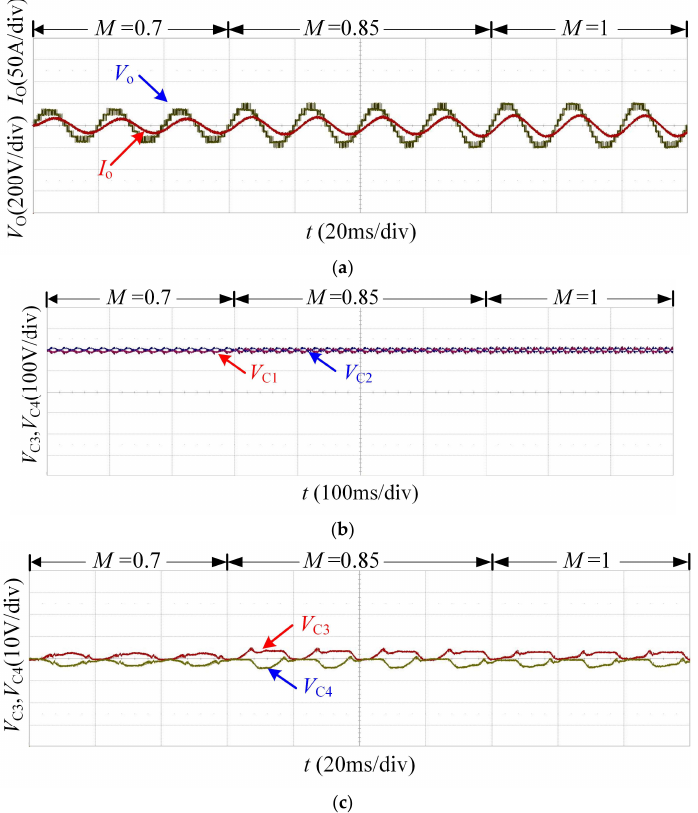
Figure 13. Experimental results of the proposed inverter with different M . ( a ) Output voltage V O and output current I O waveform; ( b ) dc-link capacitor voltage V C1 , V C2 waveform; ( c ) Suspension capacitor voltage V C3 , V C4 waveform. capacitor voltage V C3 , V C4